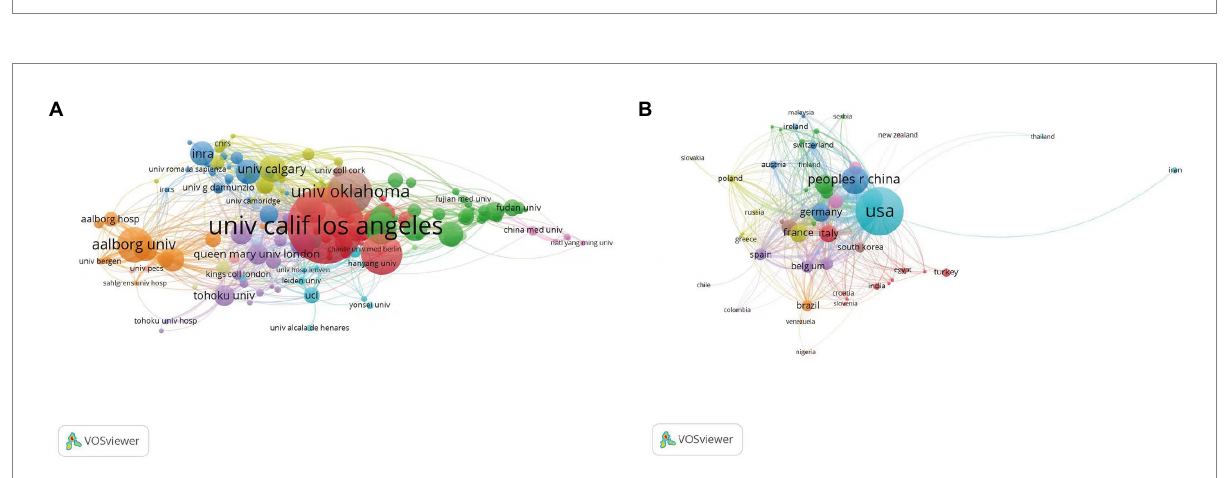
FIGURE 4 (A) The Network map of Institutions in visceral pain research ( T ≥ 10). (B) The network map of countries in visceral pain research ( T ≥ 5) Notes: The size of node reflects the institution’s or country’s published papers, the link indicate the collaborated relationship between institutions or countries, and the same color of node represent the same